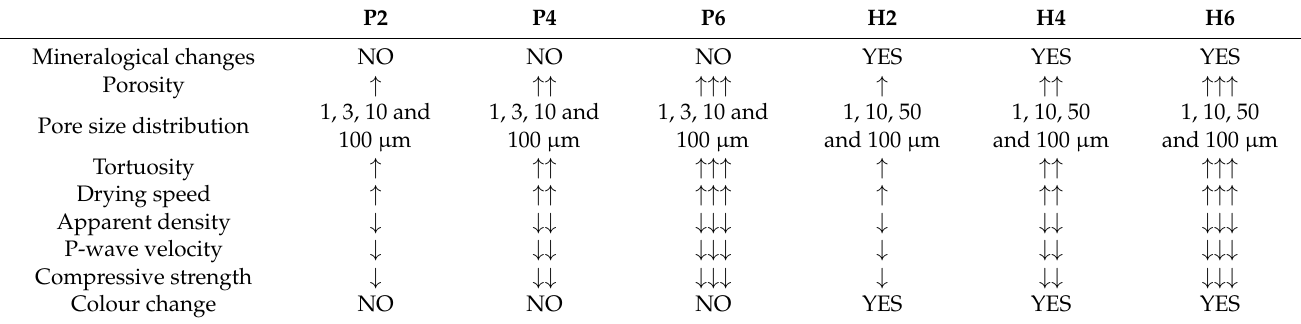
Table 5. Mineralogical and physical–mechanical differences and similarities between the bricks made with added expanded polystyrene (P), added olive stones (H) and the control samples with no additives. An upward arrow indicates that the sample had a higher value for this parameter than the control sample. A downward arrow indicates that the sample had a lower value for this parameter than the control sample. The number of arrows indicates the relative variation with regard to the control sample. P2 P4 P6 H2 H4